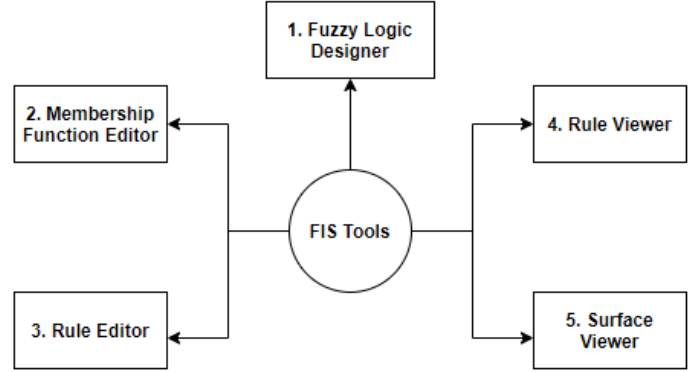
Fig. 2. Fuzzy inference system tools.